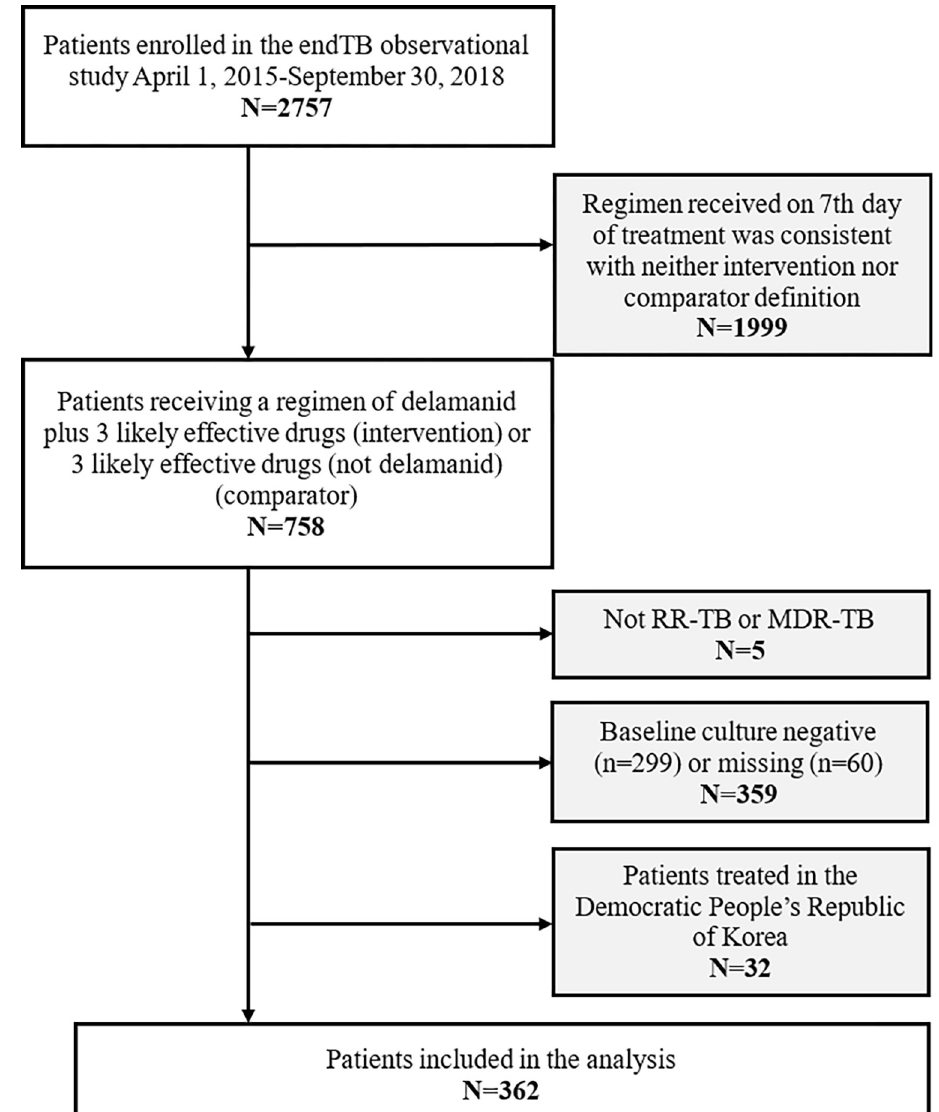
Fig 1. Flowchart of patients eligible for the comparative effectiveness of delamanid analysis in the endTB observational cohort.